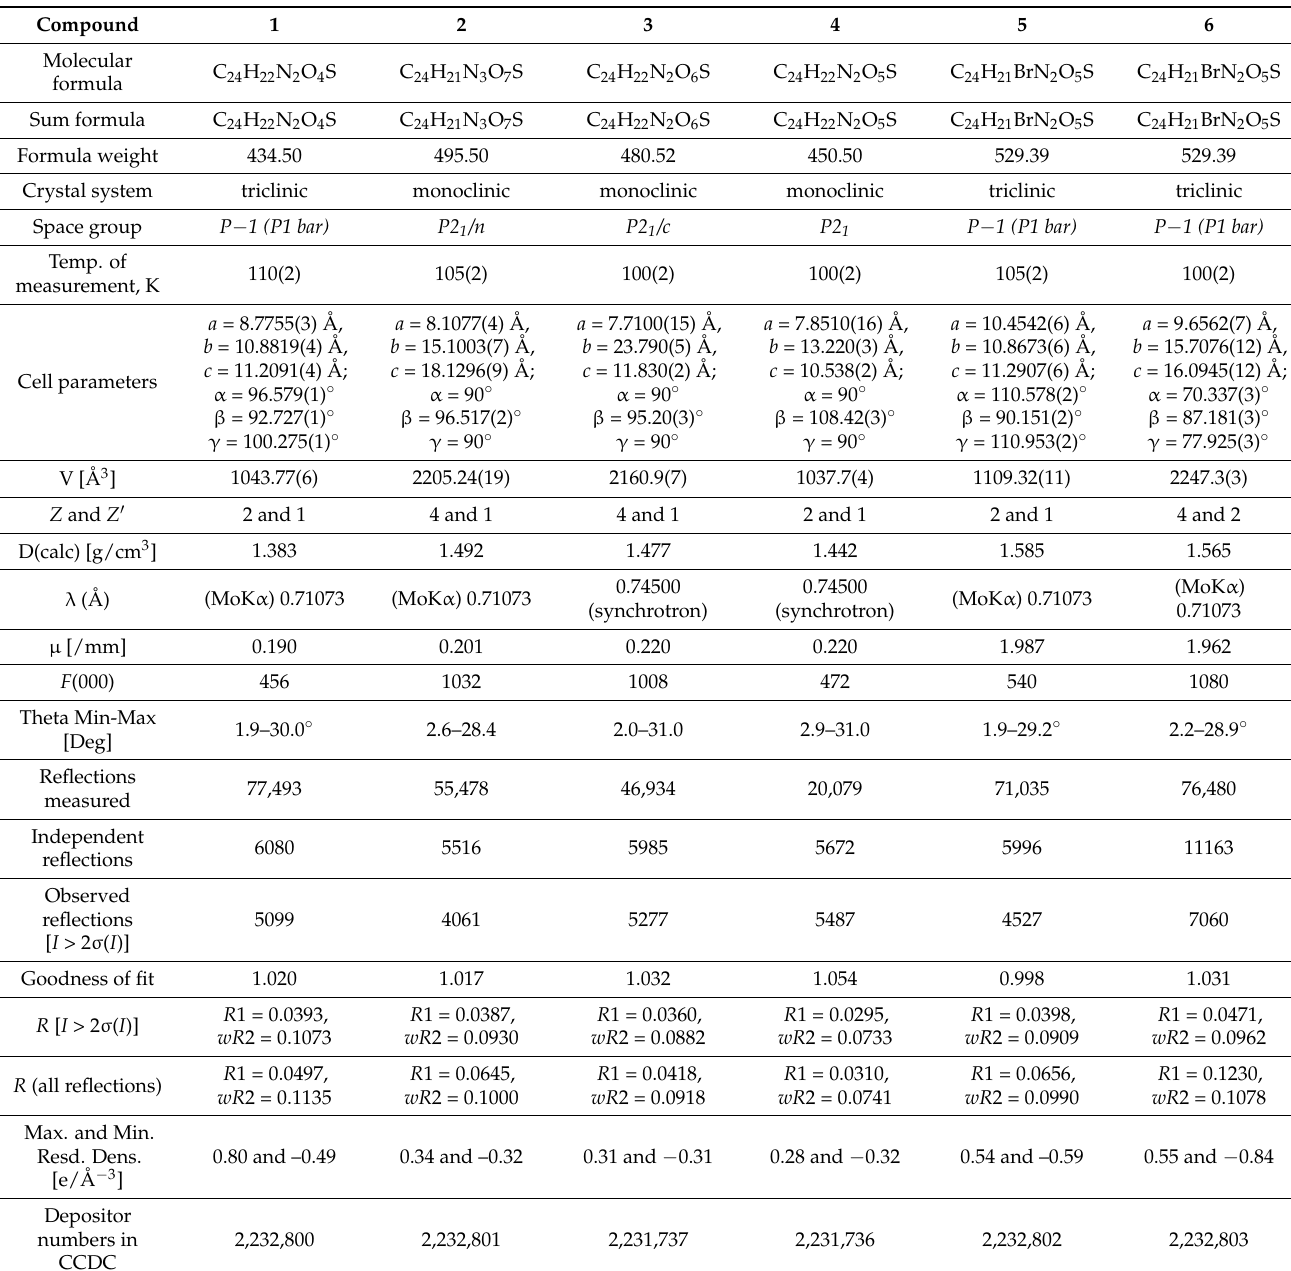
Table 2. Crystallographic data for the studied